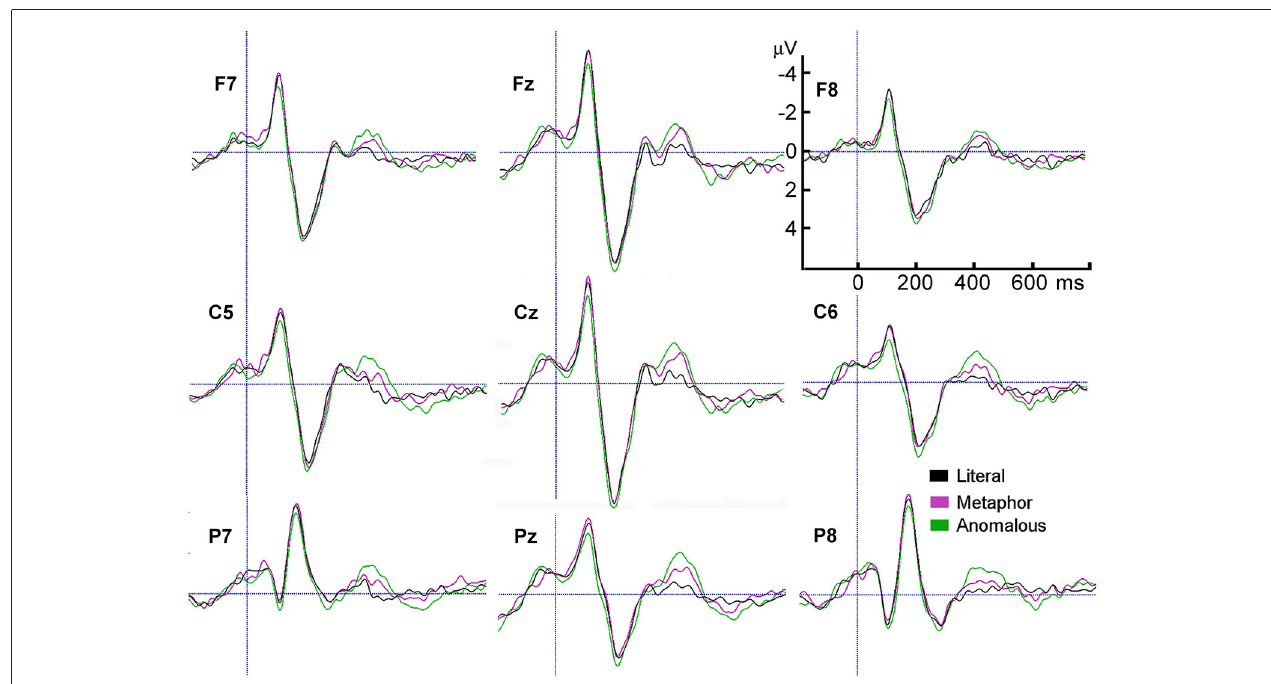
FIGURE 2 | Grand average ERPs of the last word in literal, metaphorical, and anomalous sentences, from representative electrodes in each of the 8 scalp regions plus Cz .